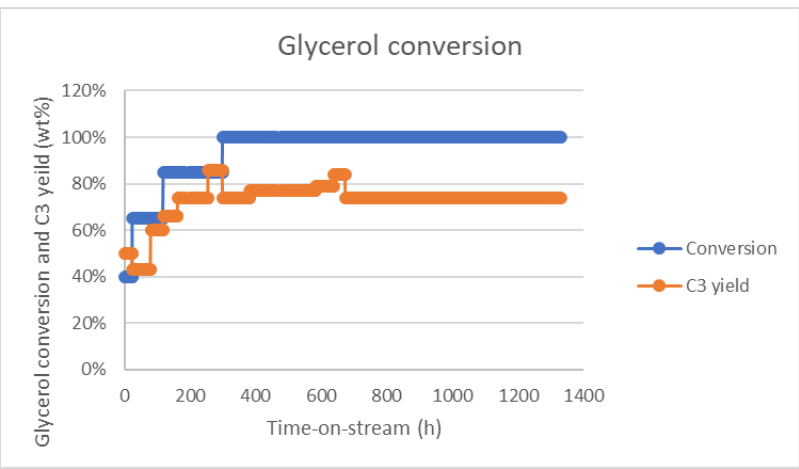
Figure 6. Conversion of glycerol and yield of C3 (acrolein and propionaldehyde) during some 1200 h of operation. Reproduced with permission [37].